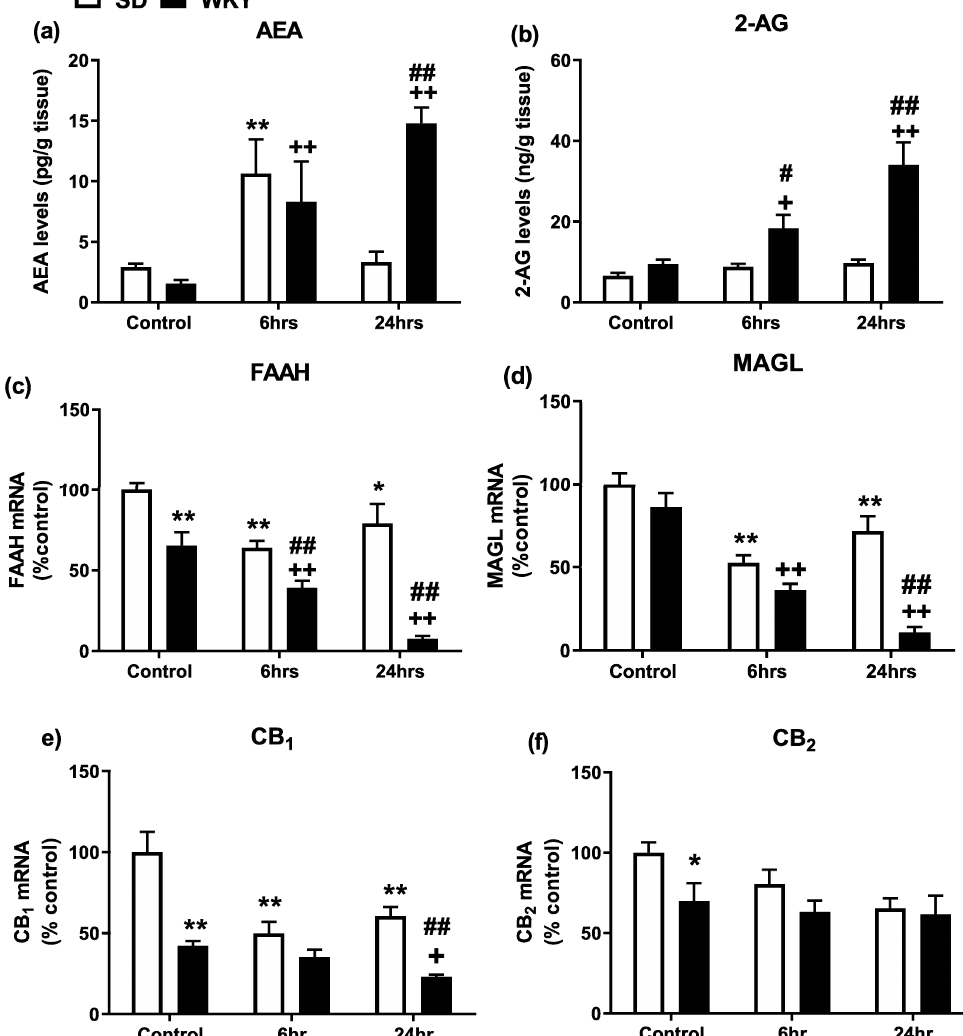
Figure 4. E ff ect of LPS / GalN on hepatic endocannabinoid system in SD and WKY rats. ( a ) AEA and ( b ) 2-AG levels. ( c ) FAAH and ( d ) MAGL mRNA expression. ( e ) CB 1 and ( f ) CB 2 receptor mRNA expression. * p < 0.05 ** p < 0.01 vs. SD saline control; + p < 0.05 ++ p < 0.01 vs. WKY saline control; # p < 0.05 ## p < 0.01 vs. SD counterparts. Data expressed as mean ± SEM ( n =